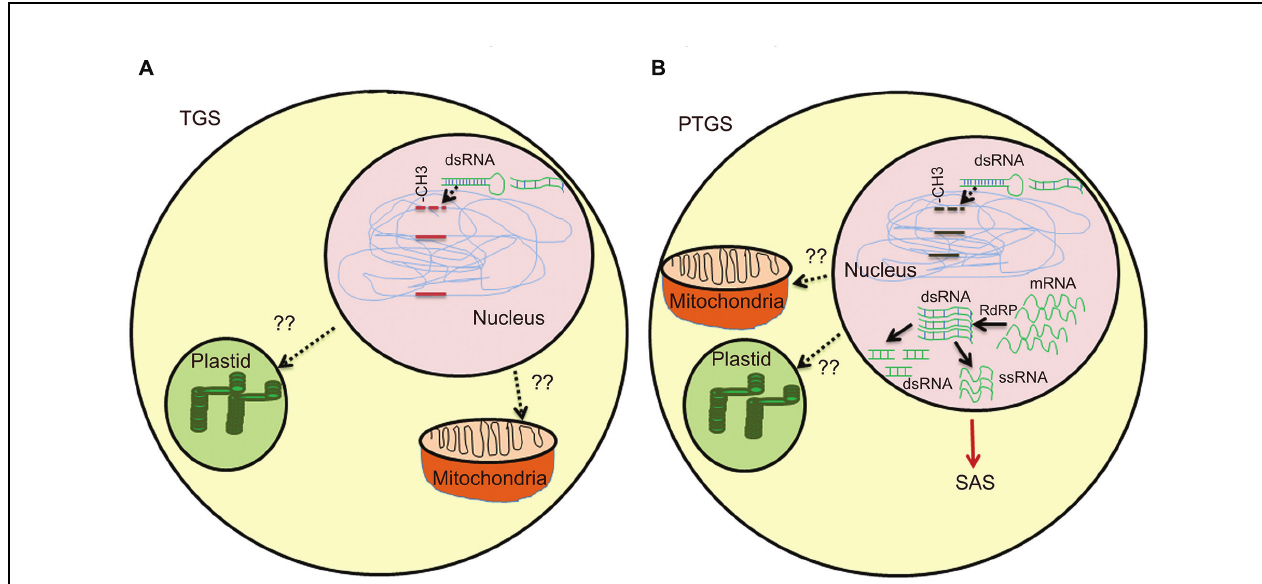
FIGURE 1 | Overview of gene silencing in transgenic plants. (A) Transcriptional gene silencing (TGS)- DNA methylation induces dsRNA by endogenous gene or multiple copies of transgenes. Presence of multiple copies of transgene induces formation of dsRNA. Single copy transgene loci could also lead to formation of dsRNA due to high RNA turnover. Methylation of CG, CNG, or CNN region in promoter by different methyltransefrases that leads to TGS. Methylation in heterochromatin region also lead to TGS. T-DNA with transgene integrated as direct or inverted (IR) repeats are inactivated by DNA methylation. Cruciform structures formed by IRs act as substrate for DNA methyltransferases. (B) Post-transcriptional gene silencing (PTGS)- Methylation in coding region and high RNA turn over lead to production of dsRNA, abbrreant RNAs, cRNAs. RdRP uses these aberrant RNAs as templates and convert them into a double-stranded RNA, which is further degraded by different dsRNases yielding small dsRNAs and/or ssRNAs. The ssRNAs and/or dsRNAs act as systemic silencing signals, which are transported all over the plant and trigger PTGS in adjacent cells. SAS in mitochondria and plastids are still under